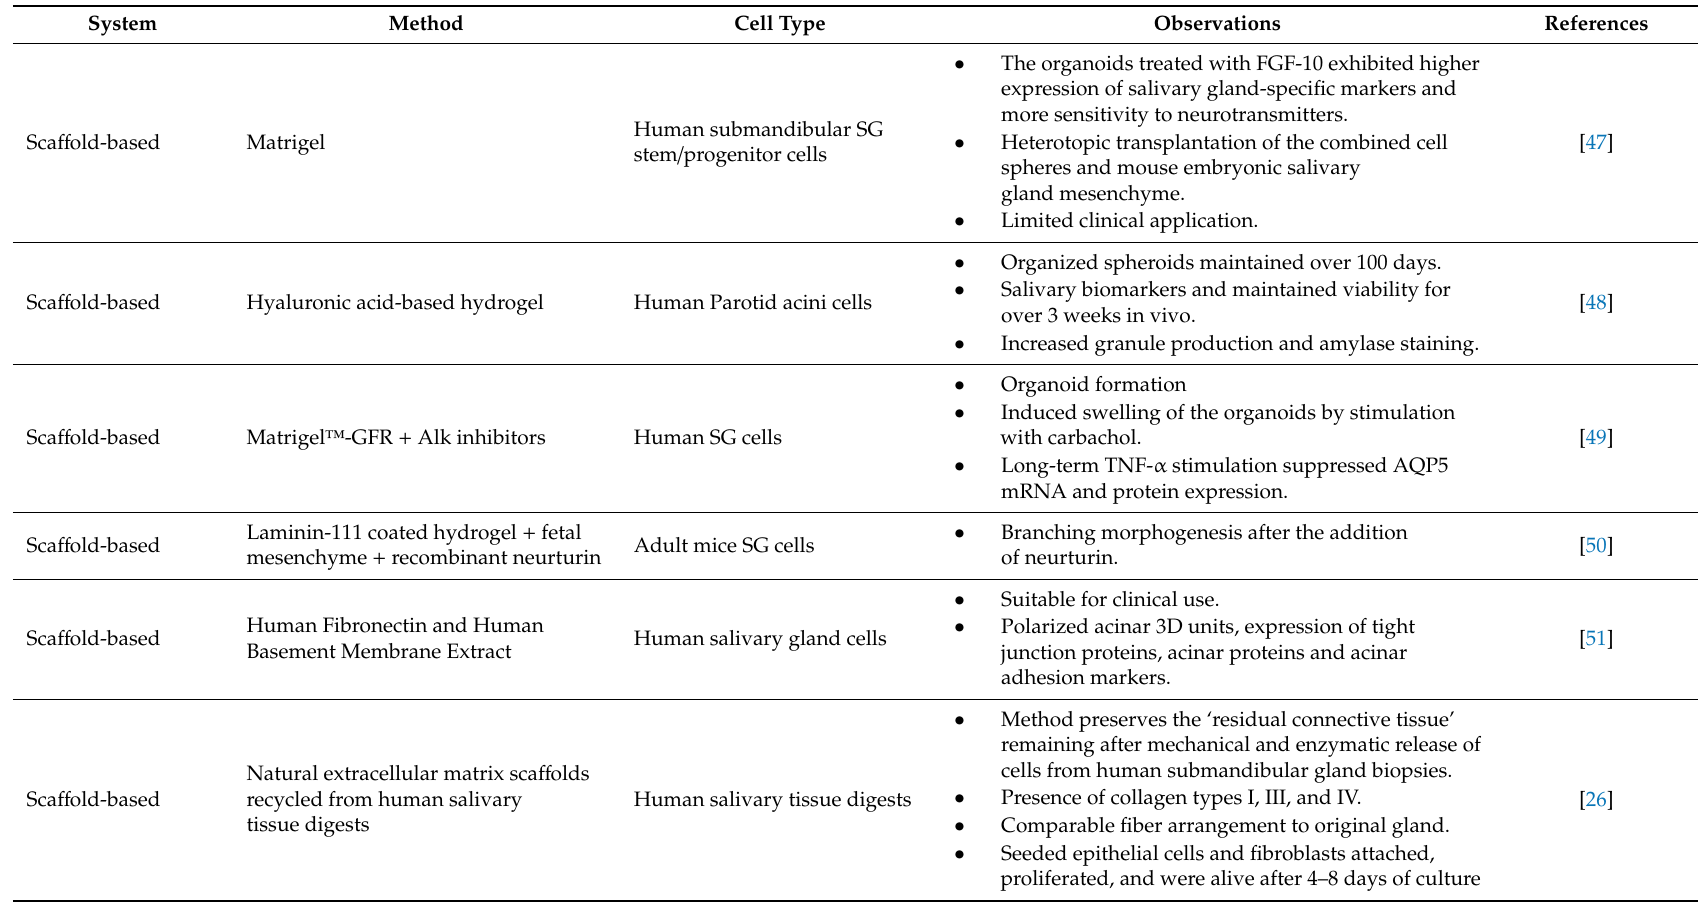
Table 2. Salivary gland 3D culture